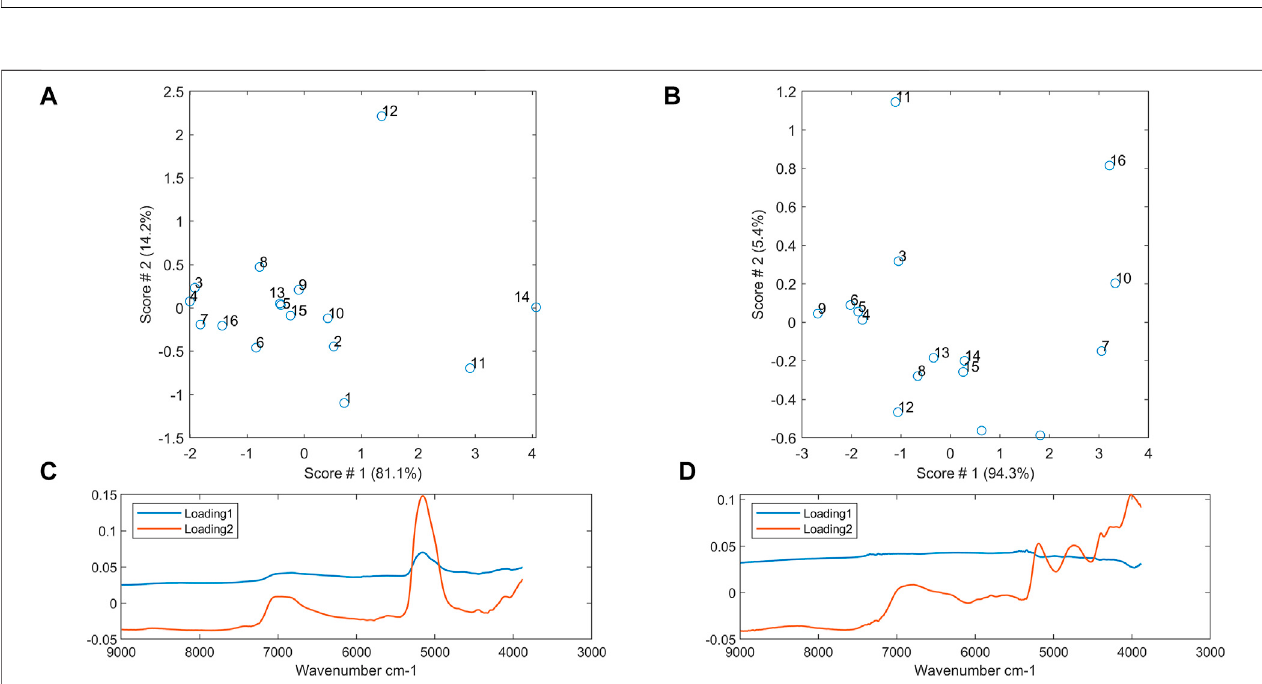
FIGURE 5 | PCA score plot of MSQ values of the nested analysis of variance at (A) subsample level and (B) replicate level. PCA loading plot of MSQ values of the analysis of variance (C) at subsample level and (D) replicate level.